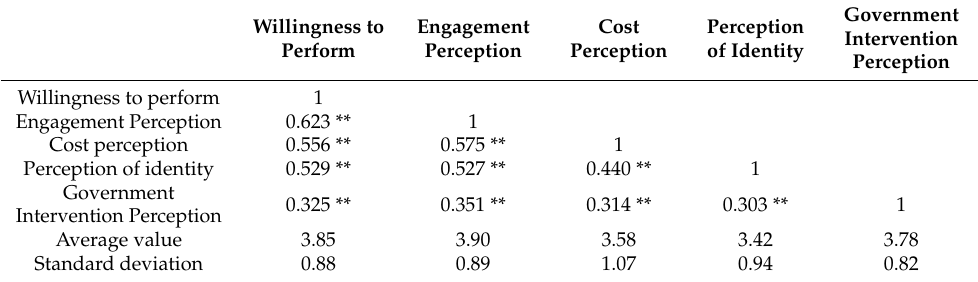
Table 11. Correlation analysis results.